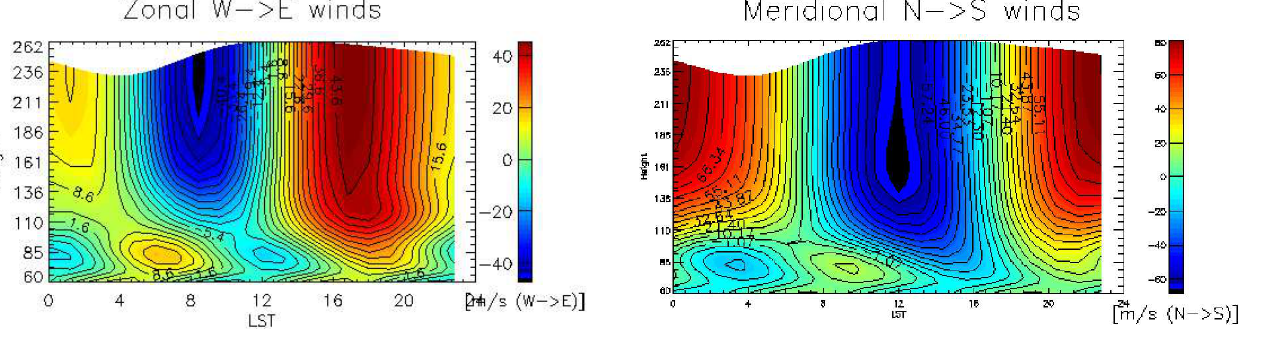
visible, yet the magnitudes are still small.